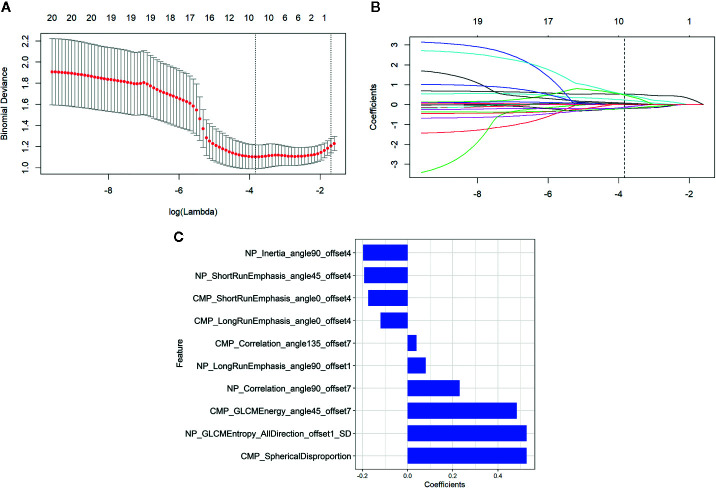
Radiomics feature selection by using the least absolute shrinkage and selection operator (LASSO) logistic regression. (A) Selection of the tuning parameter (λ) in the LASSO model. An optimal λ value of 0.022 (vertical dash line) with log(λ) = −3.836 was selected. (B) The feature coefficients varied according to log(λ). (C) The selected features with nonzero coefficients and their coefficients.